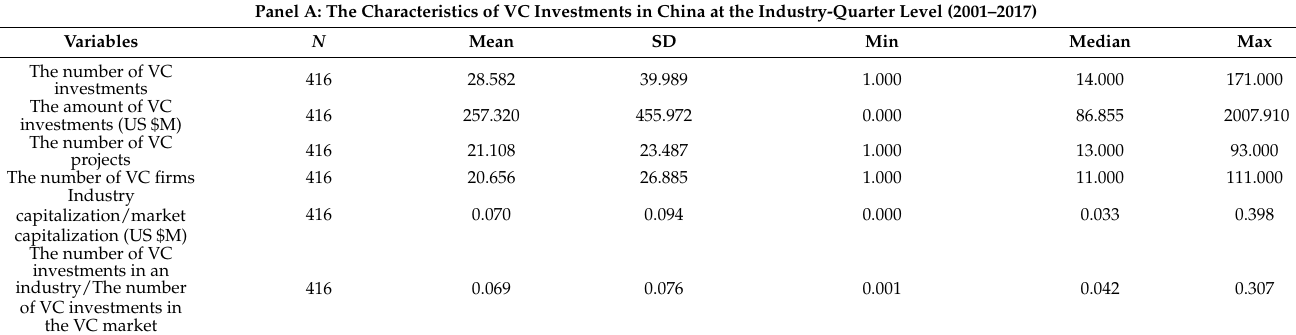
Table 2. The characteristics of VC investments in China.